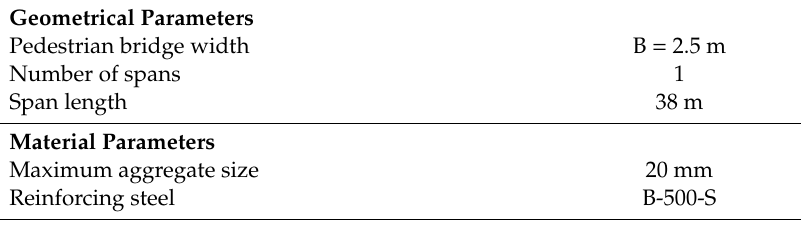
Table 2. Parameters considered in the analysis.